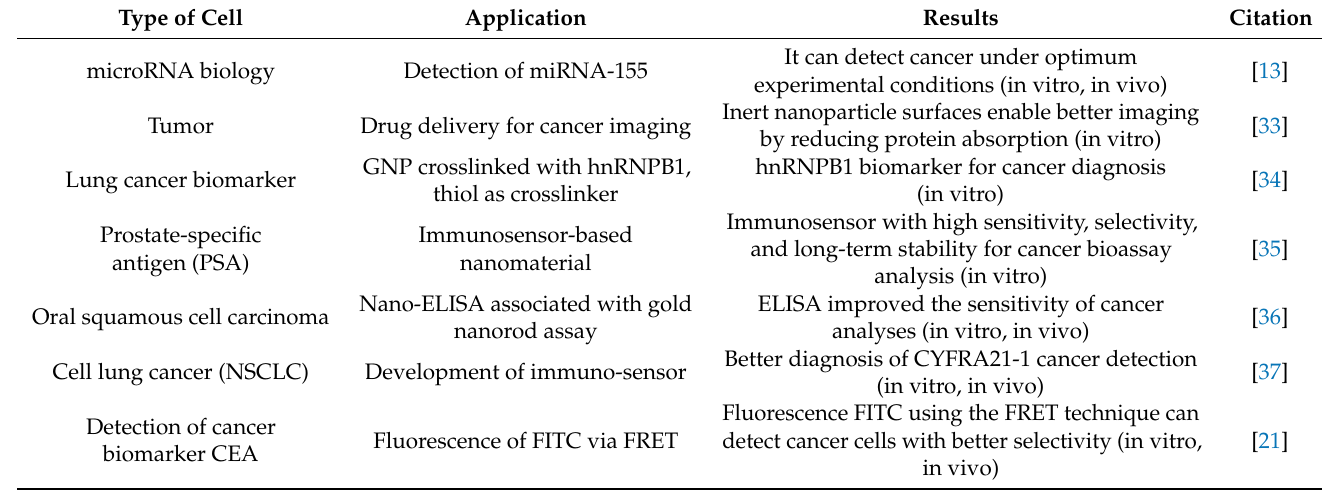
Table 4. Impact of gold nanoparticles on different cell